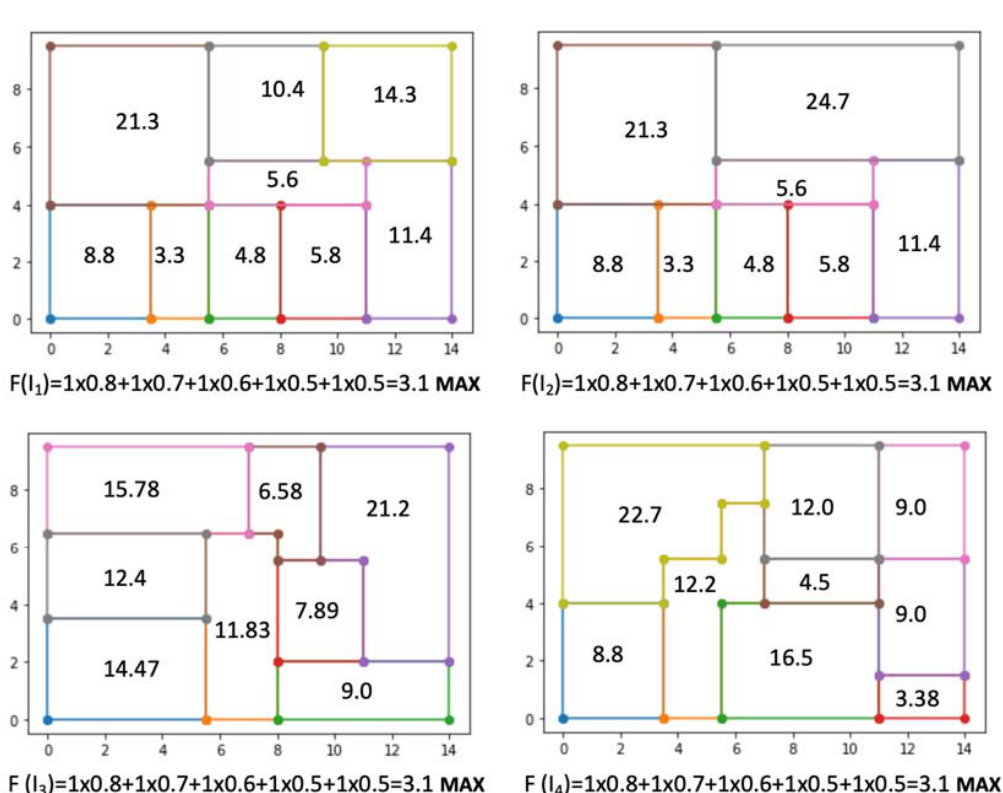
Figure 8. Four example floor plans I 1 , I 2 , I 3 and I 4 with the highest fitness value, equal to 3.1.